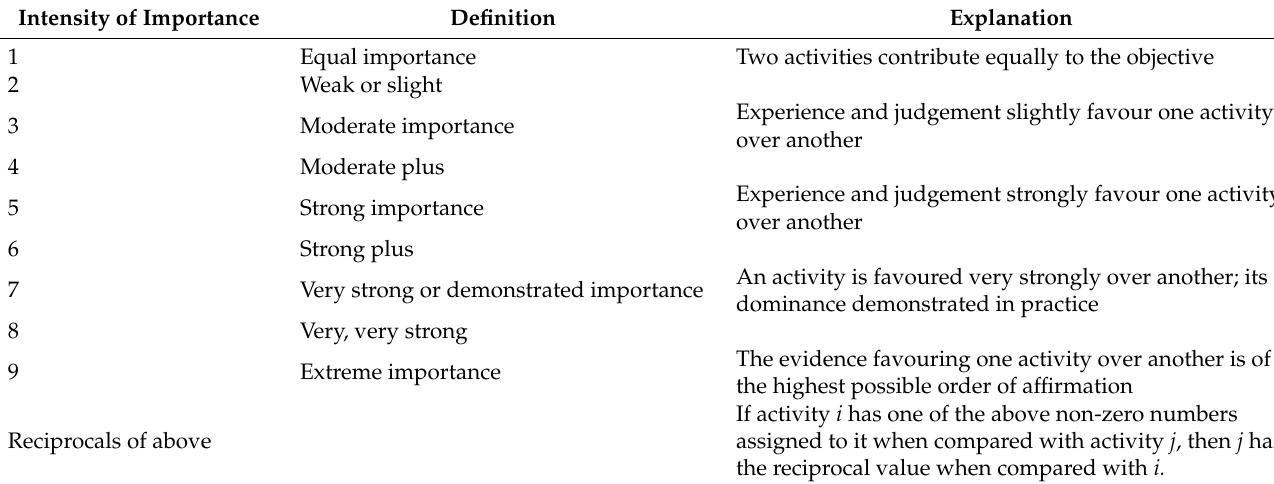
Table 4. Saaty’s Scale [59].